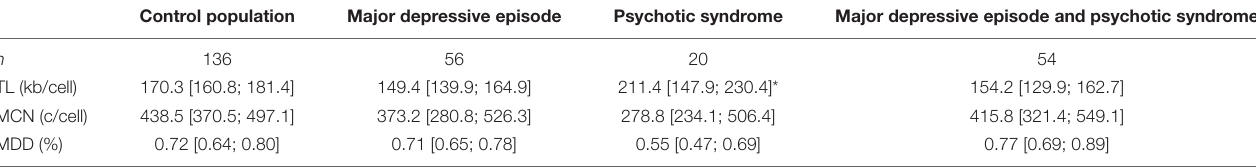
TABLE 3 | Telomere length (TL), mtDNA copy number (MCN), and deletion rate (MDD) according to psychiatric condition, median [95%CI].